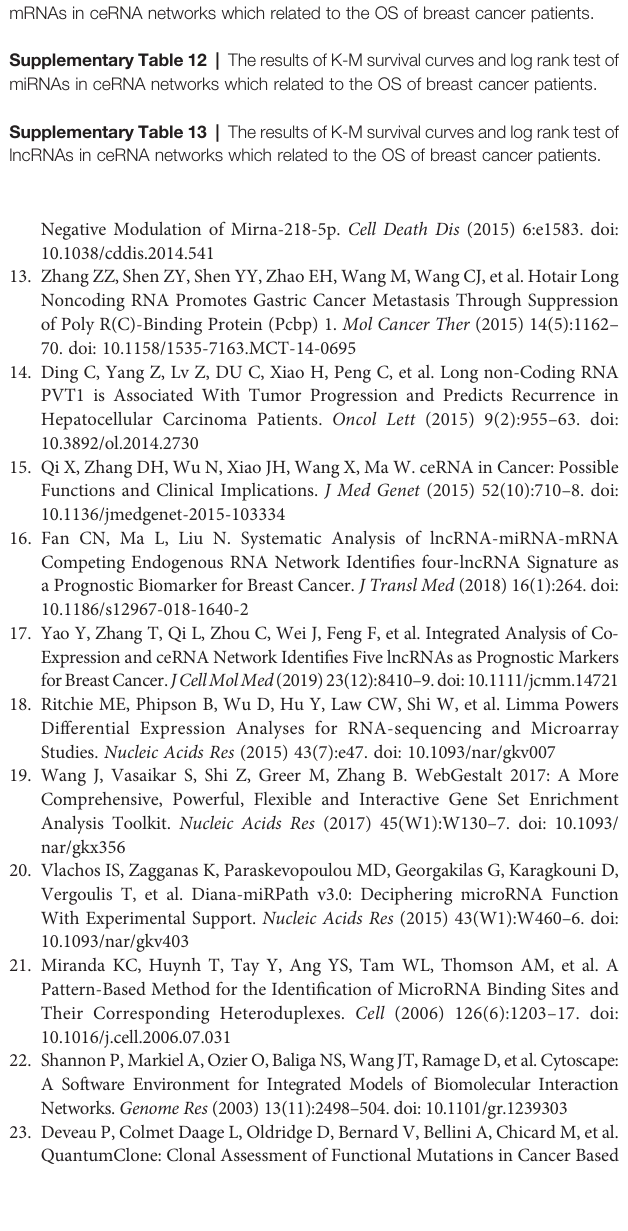
Supplementary Table 5 | Differentially expressed miRNAs between M0 and M1 samples. Supplementary Table 6 | Differentially expressed lncRNAs between M0 and M1 samples. Supplementary Table 7 | The results of KEGG pathway analysis of differentially expressed and metastasis associated mRNAs. Supplementary Table 8 | The results of GO analysis of differentially expressed and metastasis associated mRNAs. Supplementary Table 9 | Biological function of differentially expressed and metastasis miRNAs. Supplementary Table 10 | Biological function of differentially expressed and metastasis